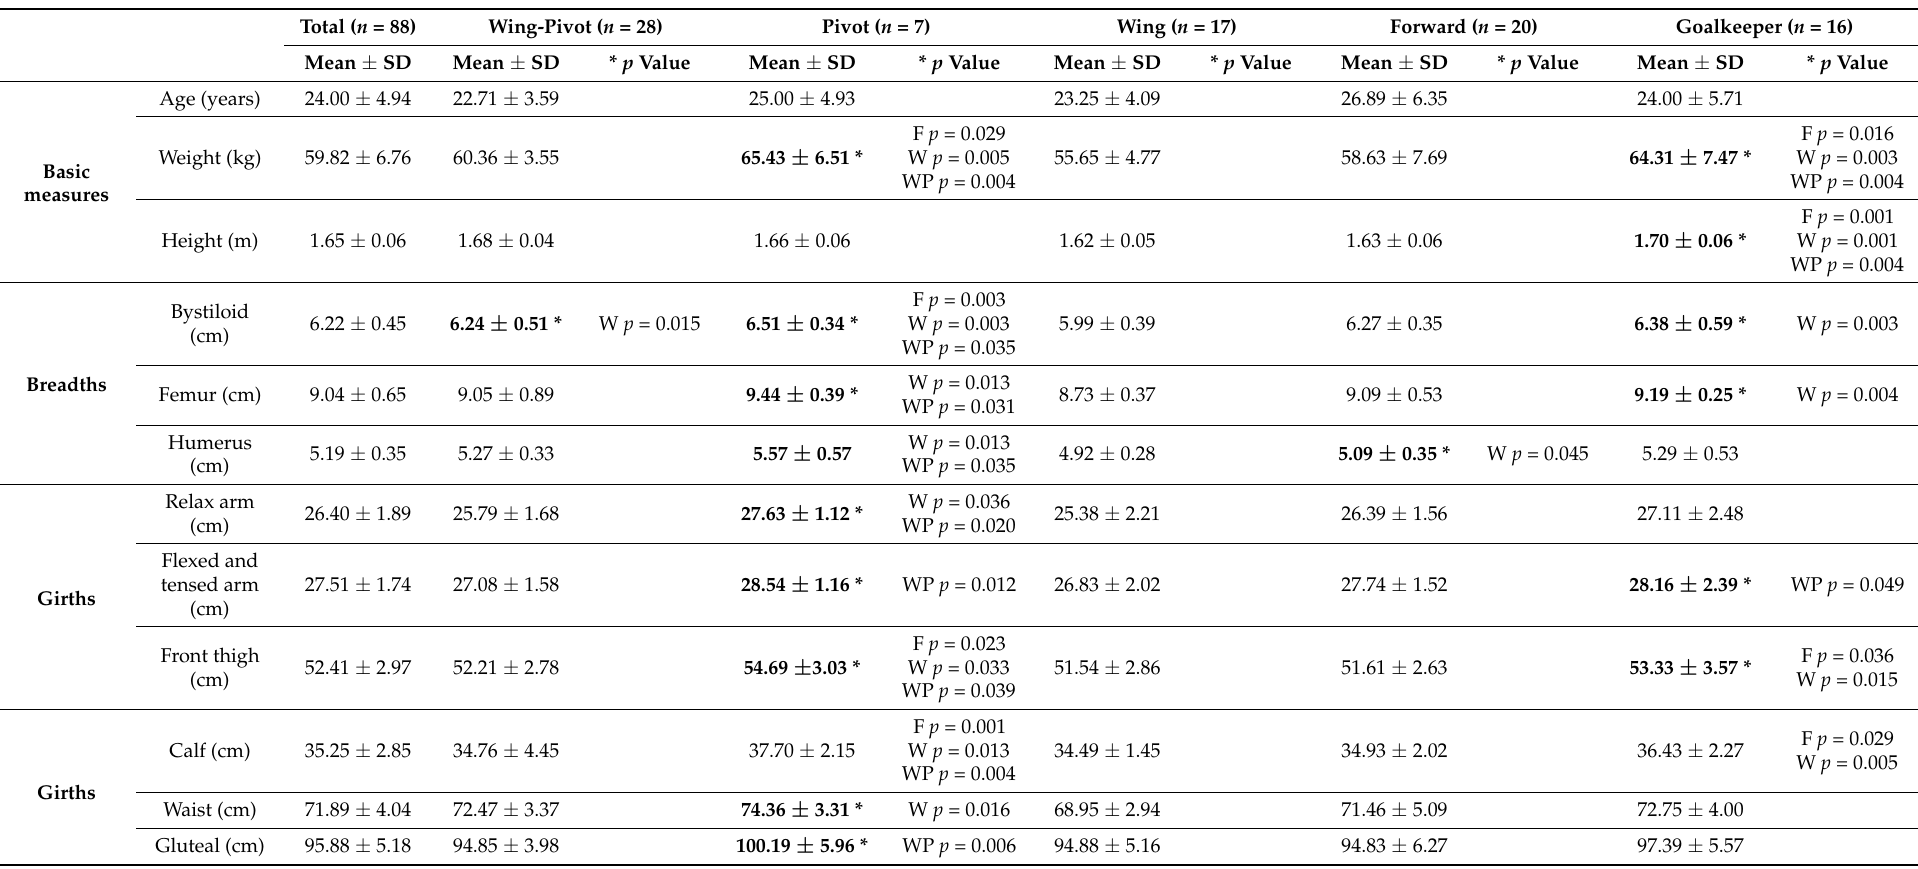
Table 1. Anthropometric characteristics of female elite futsal players according to tactical